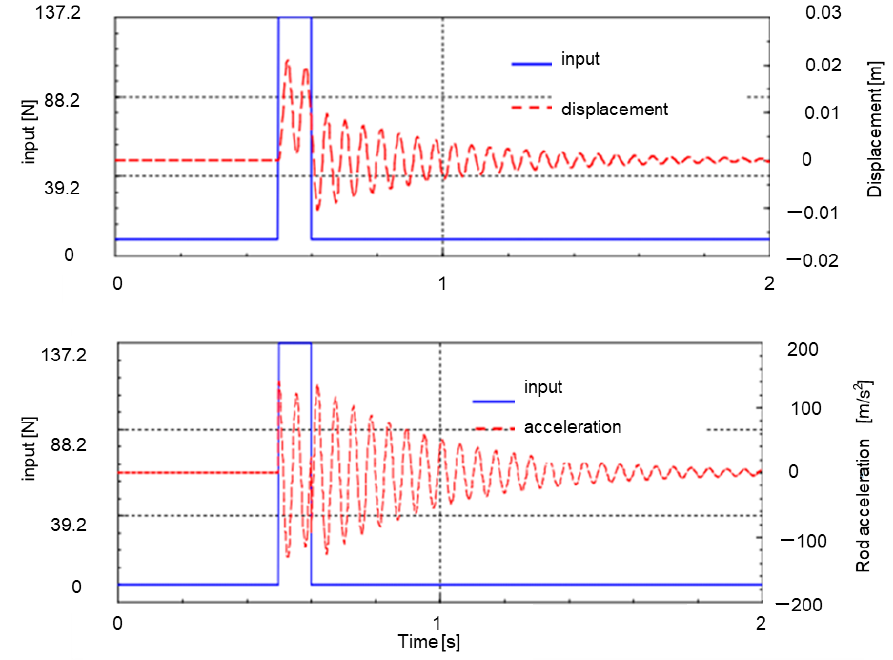
Figure 8. Time vs. rod displacement and acceleration by using spring.